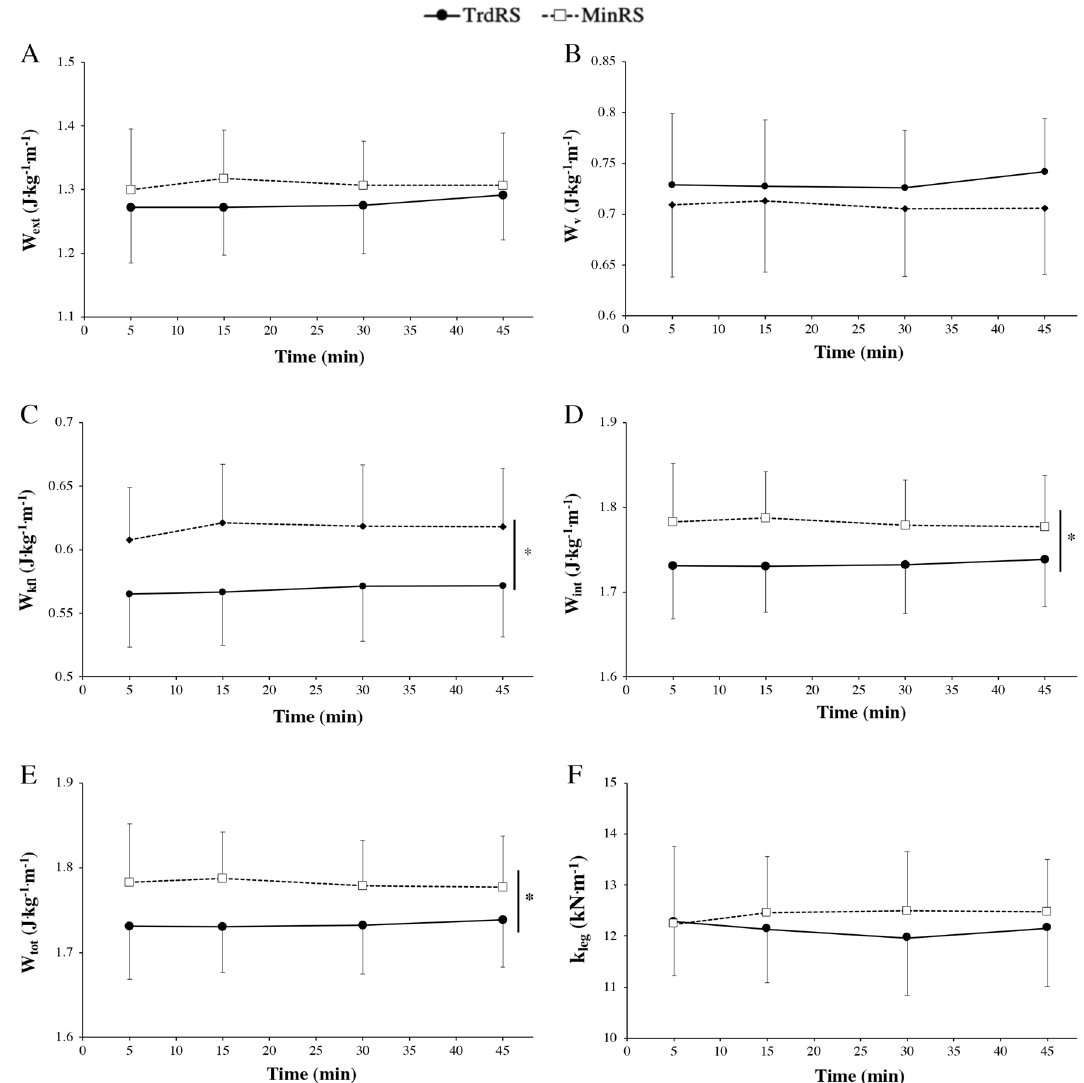
Figure 3. External mechanical work (W ext ) ( A ), vertical mechanical work (W v ) ( B ), kinetic fore-aft and lateral mechanical work (W kfl ) ( C ), internal mechanical work (W int ) ( D ), total mechanical work (W tot ) ( E ) and leg stiffness (k leg ) ( F ) versus time during the two experimental conditions [traditional cushioned (TrdRS) and minimalist (MinRS) running shoes]. Values are mean ± SD (n = 16). * indicates a significant condition effect ( P ≤